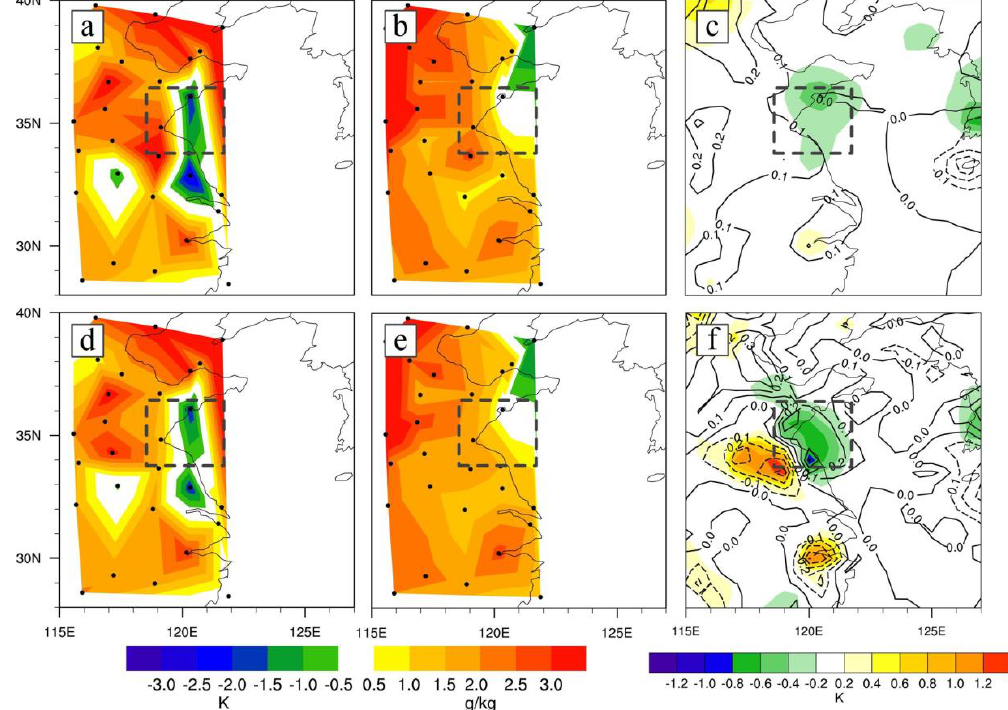
Figure 11. Comparison of observation innovation ( 𝐲 − 𝐇𝐱 𝐛 ) and analysis increment ( 𝐱 𝐚 − 𝐱 𝐛 ) at the lowest model level between Exp-B1 ( a – c ) and Exp-B3 ( d – f ) for the last DA cycle. Observation innovations of temperature and mixing ratio before and after assimilation are illustrated in the left and middle panels, respectively; and analysis increments of temperature (colors) and mixing ratio (contours, unit: g/kg) are shown in the right panels. The dots indicate the observation locations, and the dashed frame indicates the significant zone.